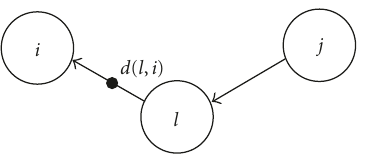
Figure 3: Modeling a latency constraint in an SRDF